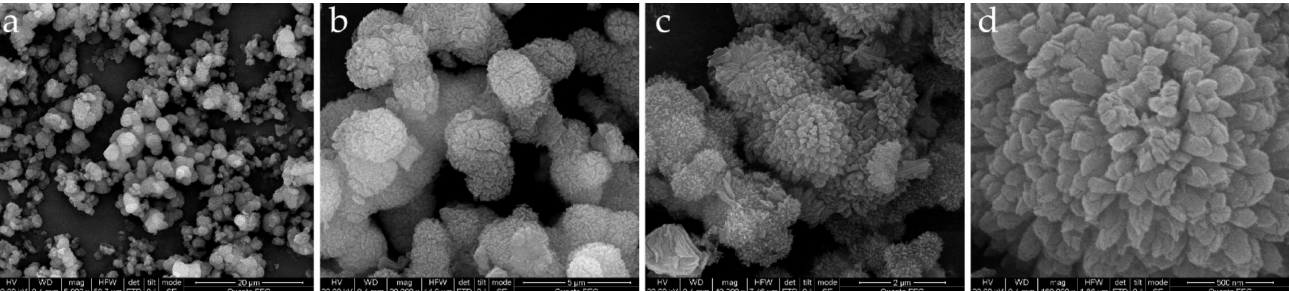
Figure 1. The scanning electron microscope (SEM) images of the NH2-Al-MIL-101 at magnification 5000 × ( a ), 20,000 × ( b ), 40,000 × ( c ) and 160,000 × ( d ).